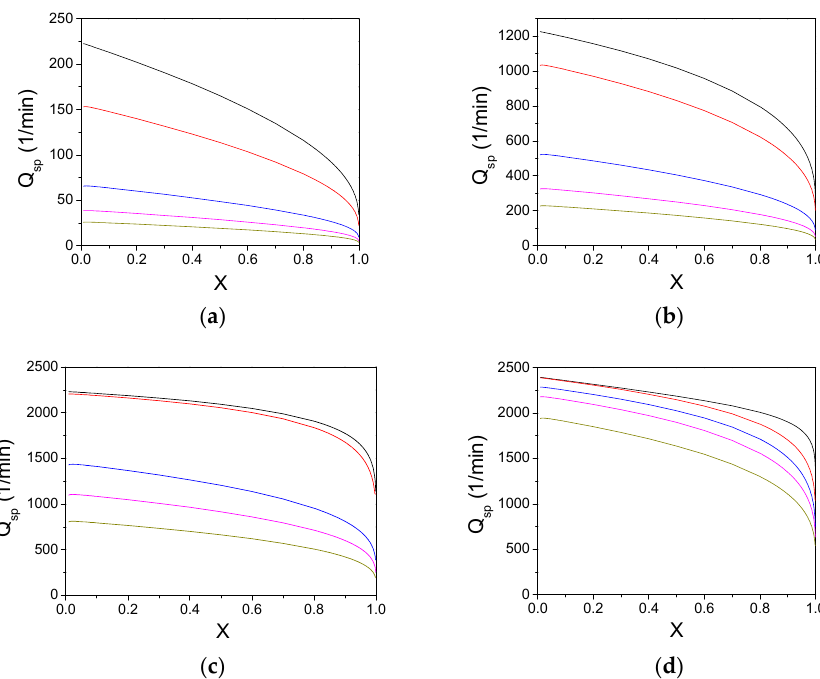
Figure 3. Specific productivities for the hydrolysis of penicillin G by soluble (black line) and immobilized PGA (color lines) for catalysts with different initial PenG concentrations (S 0 /K M ) and Thiele moduli ( Φ ): ( a ) S 0 /K M = 0.1; ( b ) S 0 /K M = 1.0; ( c ) S 0 /K M = 10; ( d ) S 0 /K M = 100. All specific productivities were calculated from data in Figure 2. Legends are the same as those in Figure 2.